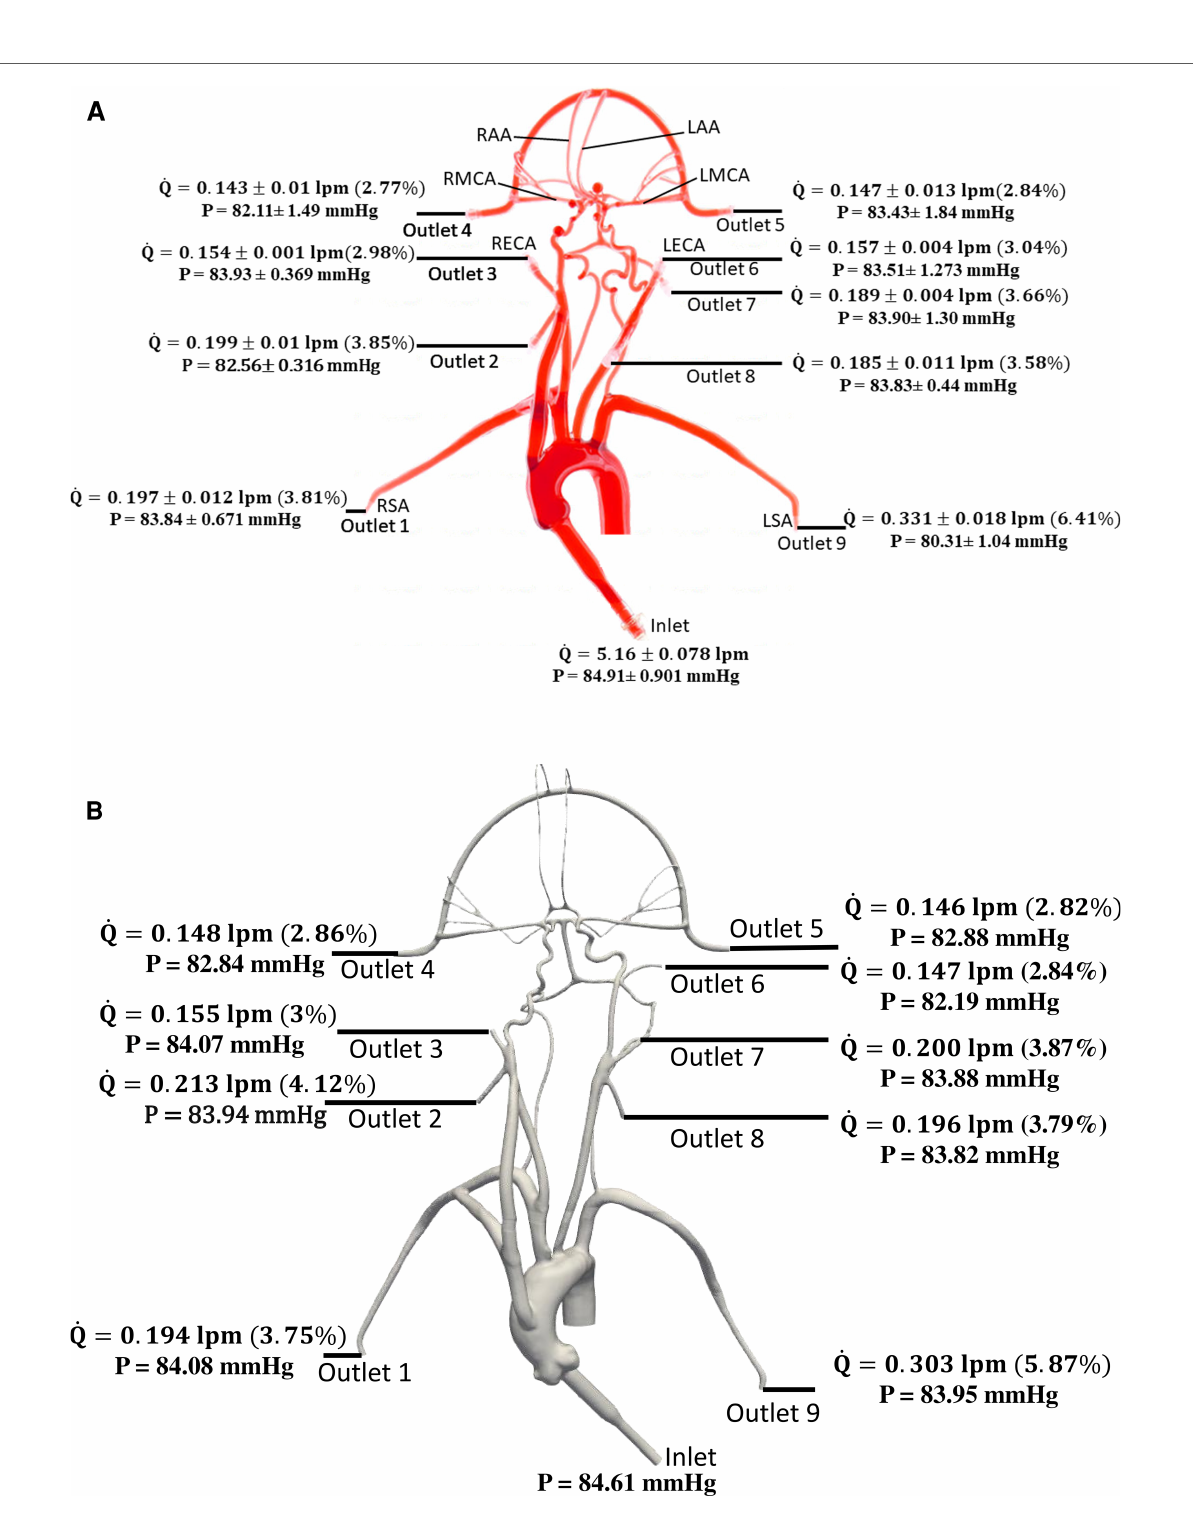
FIGURE 3 Mean volumetric fl ow rate and pressure values along with standard deviation at the inlet and all arterial outlets from ( A ) in vitro experiments and ( B ) CFD simulation for the normal condition. The percentage values shown in parentheses indicate the fraction of total inlet fl ow through each arterial